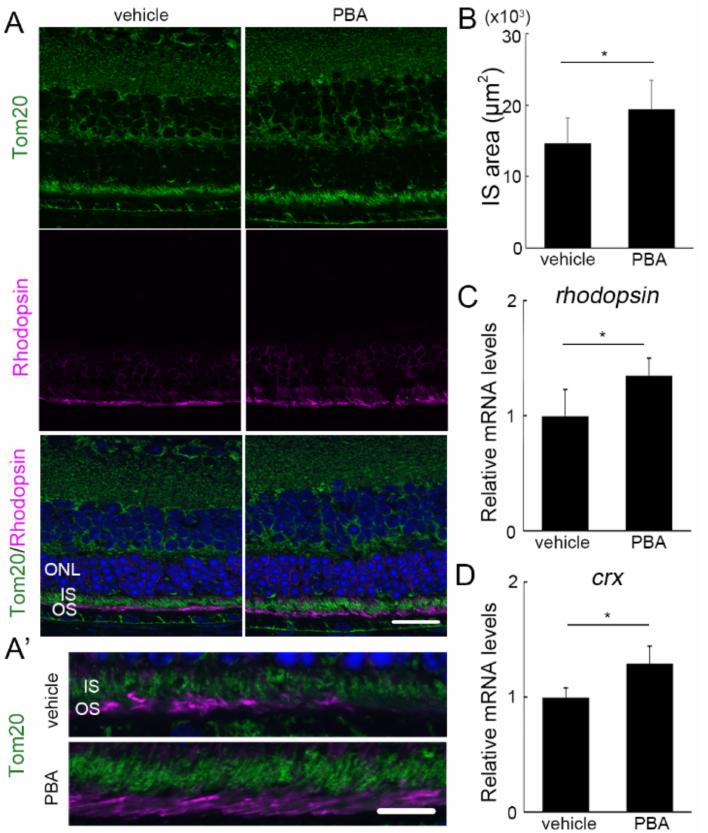
Figure 3. Protective effect of PBA in the photoreceptors of P23H RP models detected before pho- toreceptor loss ( A , A’ ) Immunohistochemistry for Tom20 (green) and rhodopsin (pink) in the retina of P23H RP models at the age of 4 weeks with or without PBA treatment. Nuclei were counterstained with DAPI (blue). ( A ’) Magnified images of IS and OS. IS area ( B ), and mRNA levels of rhodopsin ( C ) and crx ( D ) in the retina were already different with or without PBA treatment. Data are shown as mean ± standard deviation. Respective n for P23H RP models treated with vehicle and PBA, ( B ) 4 and 5; ( C ) 5 and 4; ( D ) 10 and 10. ONL, outer nuclear layer; IS, inner segments; OS, outer segments. * p < 0.05. Scale bar, ( A ) 20 µ m; ( B ) 10 µ